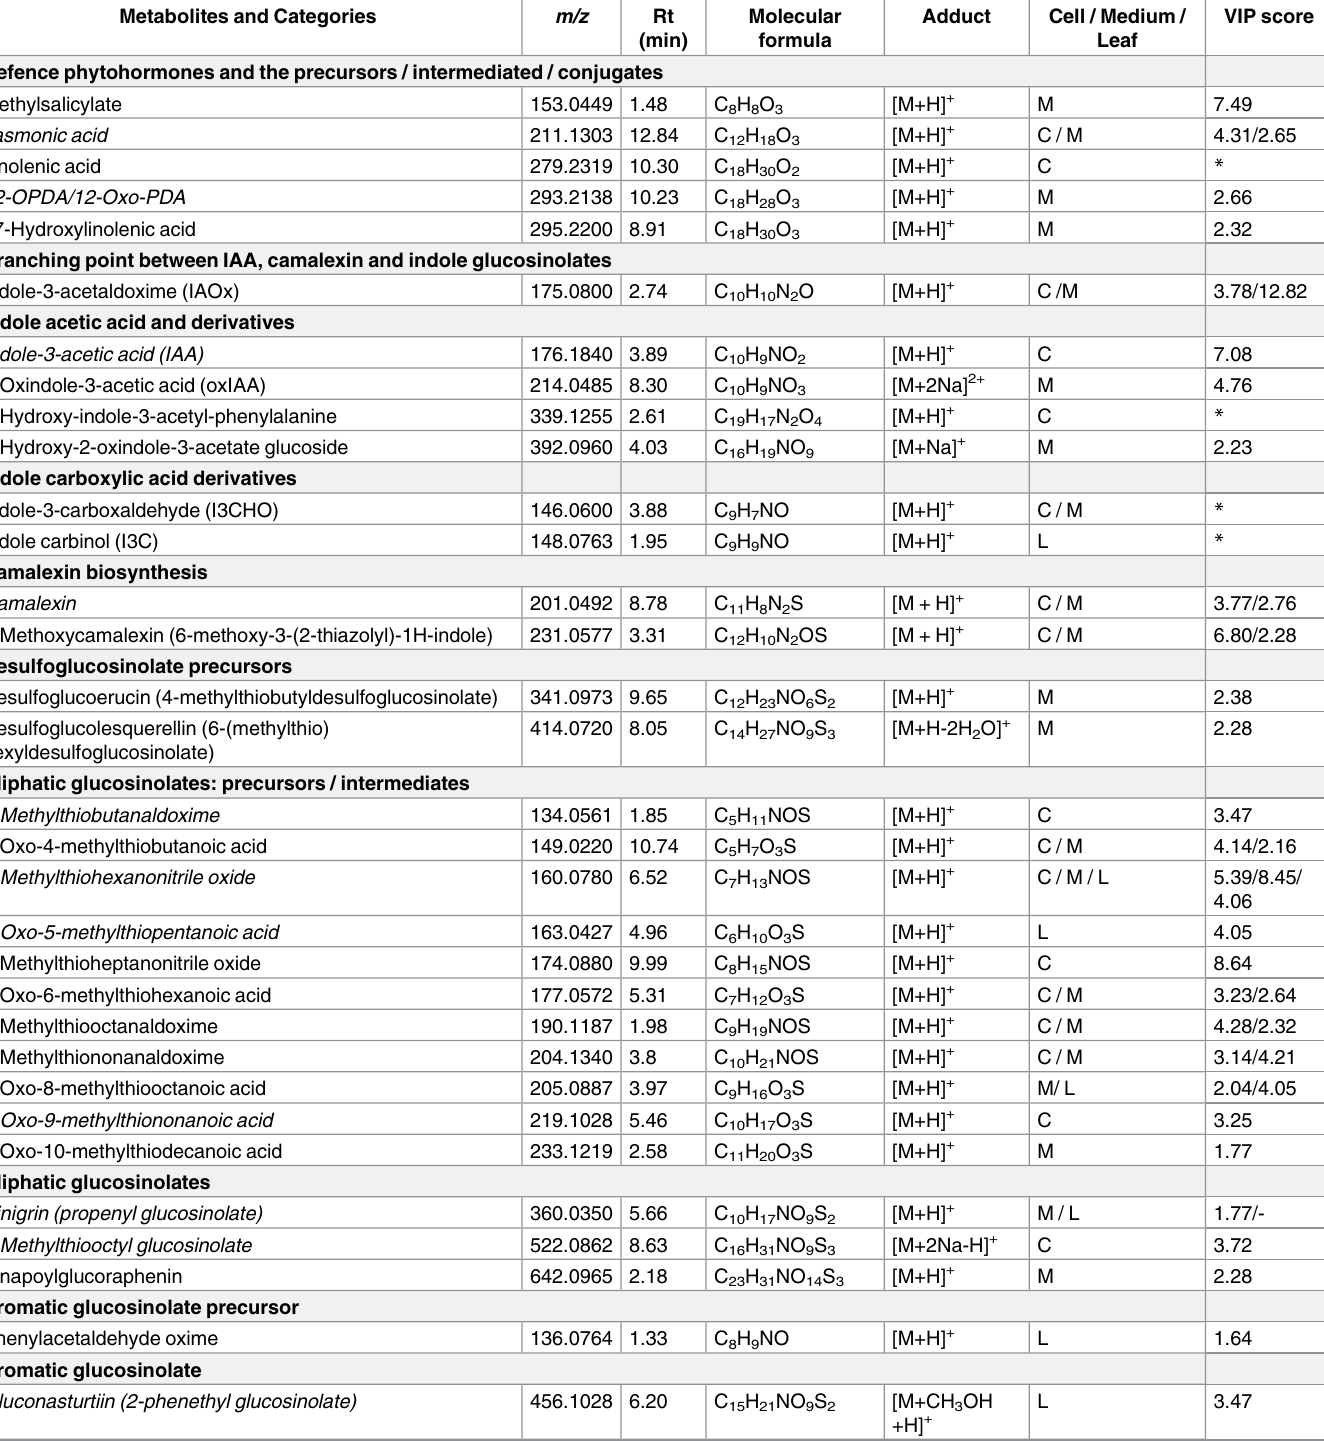
Table 2. Summary of annotated metabolites, analysed by high definition MS in ESI positive mode, in extracts from LPS-treated A . thaliana cells and leaf tissues. Metabolites that contributed to the discriminating variability in the altered metabolomes were identifiedbased on OPLS-DA S plots, with VIP-score values > 1 indicated.Metabolites annotatedfrom volcano plots are indicated in italics . Metabolites indicatedwith an asterix were annotatedapply- ing the PUTMED-LCMS workflows [48]. Annotations correspond to the metabolite identification (MI)-level 2